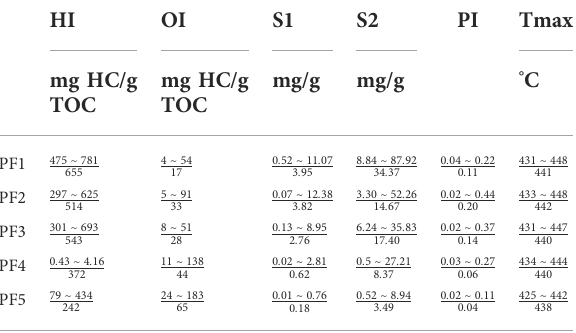
TABLE 2 Pyrolysis characteristics of